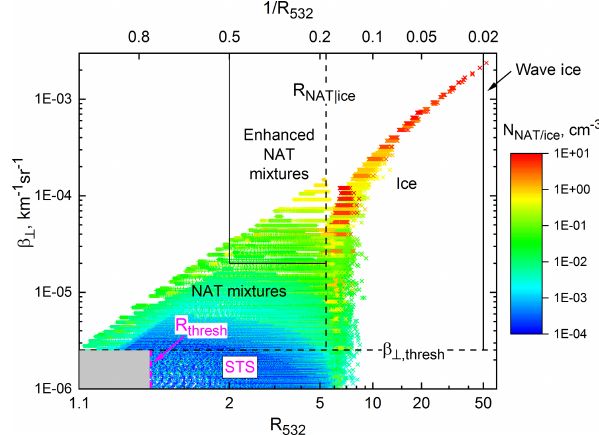
Figure 4. Theoretical optical calculations for non-equilibrium liquid–NAT and liquid–ice mixtures, illustrating the v2 PSC com- position classification scheme. The grey box at the lower left fall represents points that fall below both CALIOP v2 PSC detection thresholds and are classified as